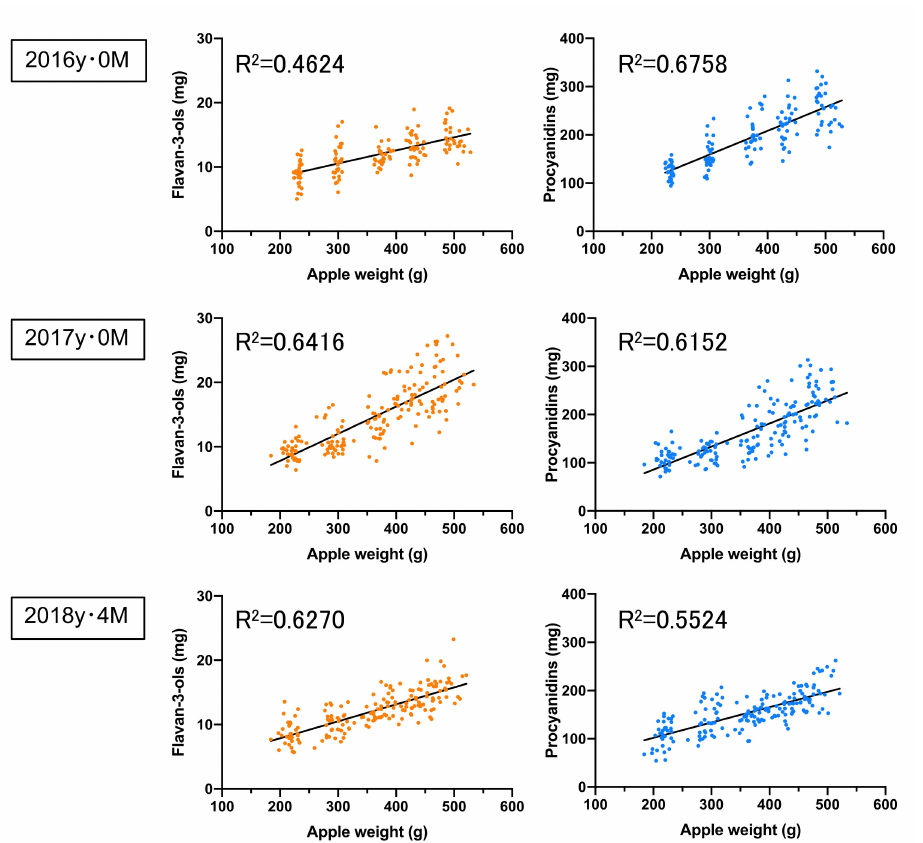
Figure 4. The correlations between the apple weights and both the flavan-3-ol and the procyanidin concentrations in the non-bagged ‘Orin’ apples. The apples were analysed in 2016y · 0M ( n = 148), 2017y · 0M ( n = 177), and 2018y · 4M ( n = 179), where y refers to the year, M refers to the month, and n refers to the number of